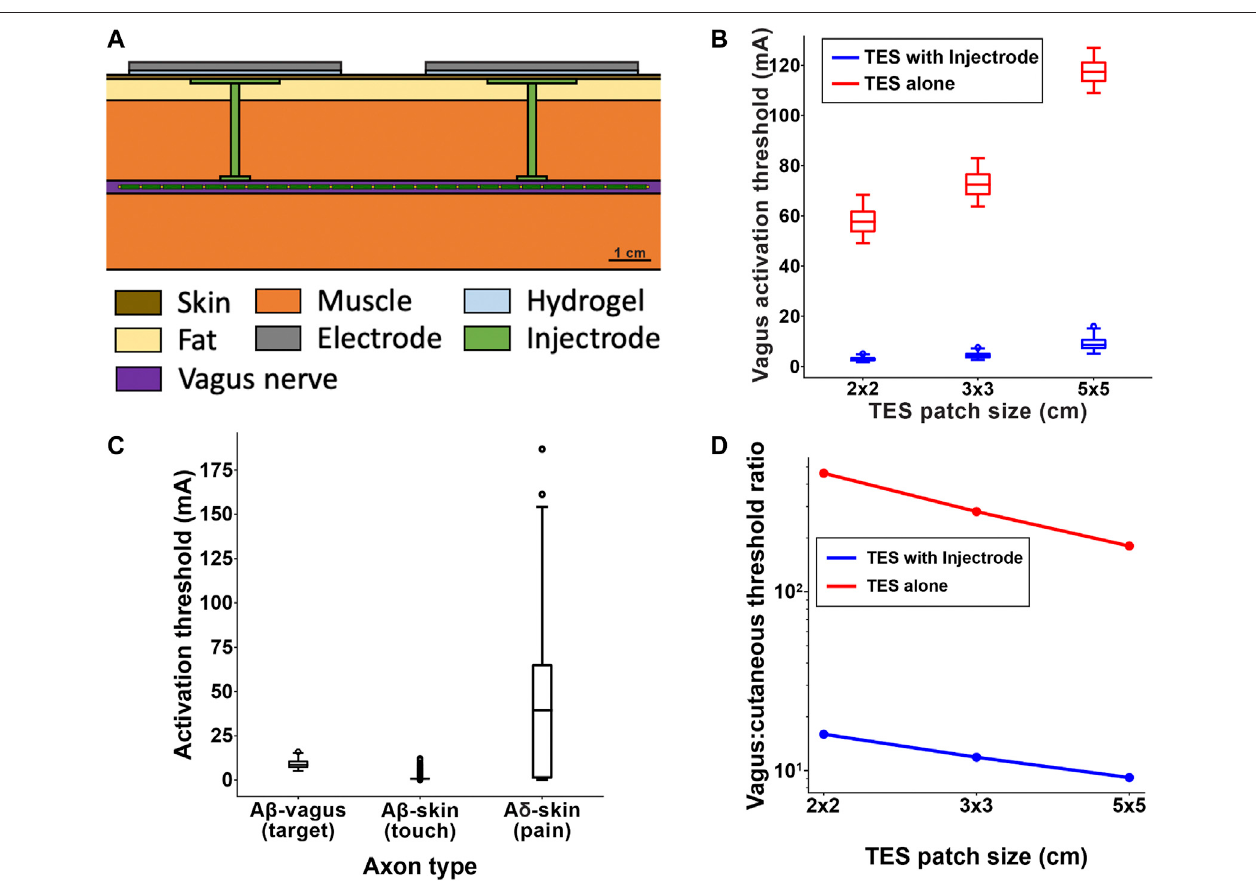
FIGURE 7 | (A) Full FEM model used in the biophysical study. The 1 k Ω resistor between the two collectors in the simpli fi ed transcutaneous coupling FEM model was replaced with the vagus nerve, Injectrode connections down to the vagus nerve, and Injectrode interfaces with the vagus nerve. This sub fi gure is reproduced from Figure 2C . (B) Box plot of all axons showing that the Injectrode system reduced the current required to activate A β vagal fi bers by more than an order of magnitude comparedtousingonlysurfaceelectrodes.ThislargedifferencewasseenacrossTESpatchesofdifferentsizes. (C) Boxplotofactivationthresholdsofallon-target A β vagal fi bers compared to all off-target A β cutanoues fi bers responsible for paresthesia and off-target A β cutaneous fi bers responsible for noxious sensations. (D) InvestigatingtheeffectofTESpatchsidelengthoncutaneousand vagusA β - fi ber activation.IncreasingtheTESpatchsidelengthincreasedmedianthresholds,andthis effectwaslesspronouncedinvagalA β fi bers,improvingtheratioofA β vagalactivationtoA β cutaneousactivation.TheInjectrodesystemachievedpreferentialon-target activation one to two orders of magnitude better than using surface stimulation electrodes